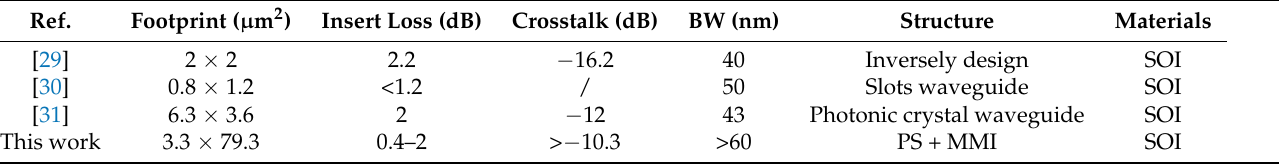
Table 1. Comparison the proposed silicon E 00 -E 10 mode converter with reported